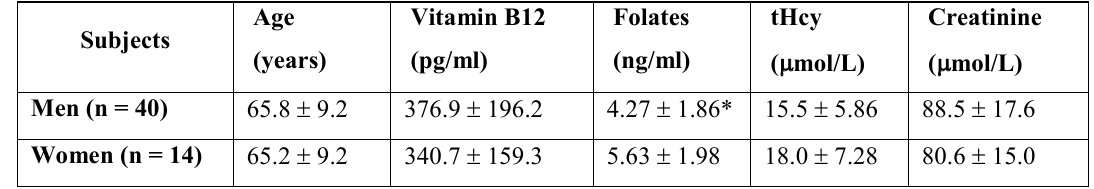
Table 1. Gender influence on biological markers in the study population (total homocysteine = tHCy). n = 54 (Age ≥ 51 years). *p < 0.05